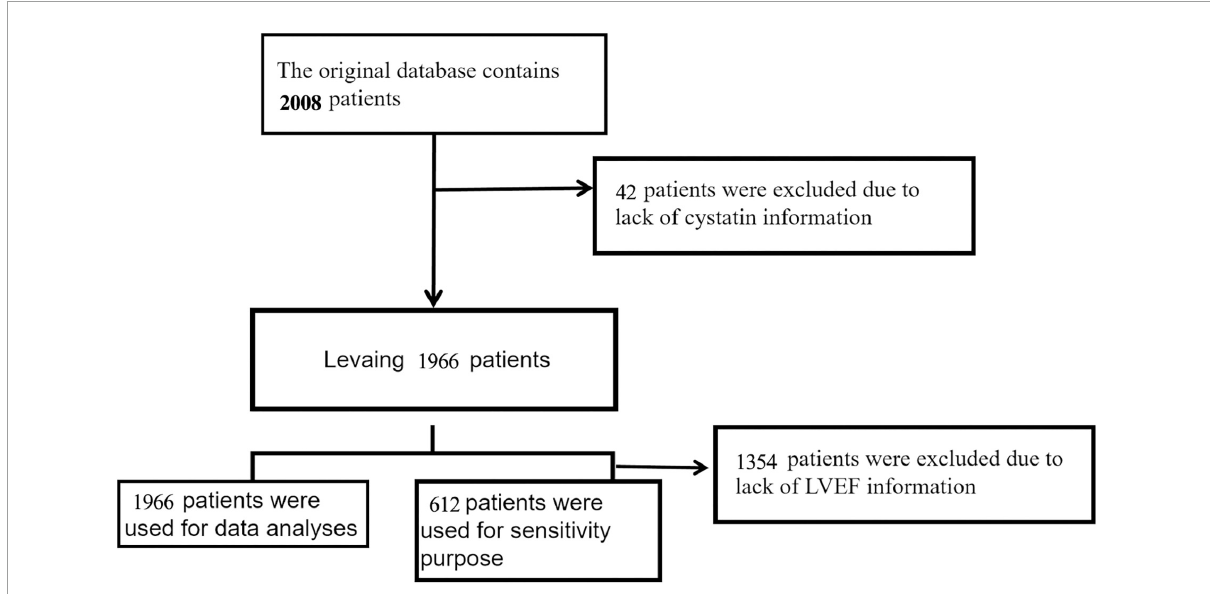
FIGURE1 The flowchart of patients selection.